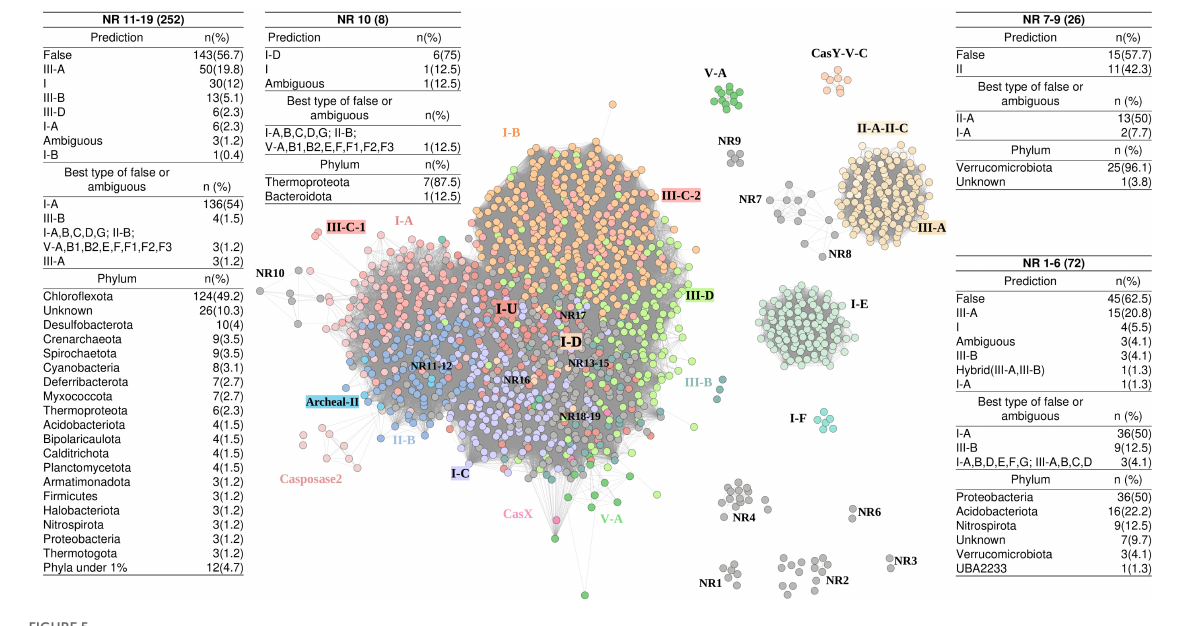
FIGURE5 Similarity network of 1,468 representative Cas1 proteins obtained from 2,150 Cas1 from 48 hot spring metagenomes. Points are colored according to the clades of the phylogenetic tree in Figure 4 . Specific consolidated typification of NR (no reference) Cas1 clades is indicated in boxes, where the nomenclature of “ambiguous” or “false” was taken from Russel et al. (2020), meaning non-hybrid operons with two or more cas subtypes and the same scoring, or neither hybrid nor ambiguous operons, respectively. NR5 is represented by one sequence and as a singleton in the network (not